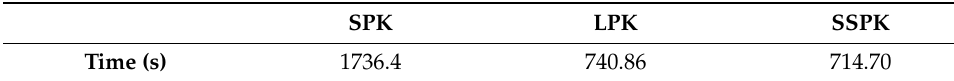
Table 10. Computational time for the fifth case